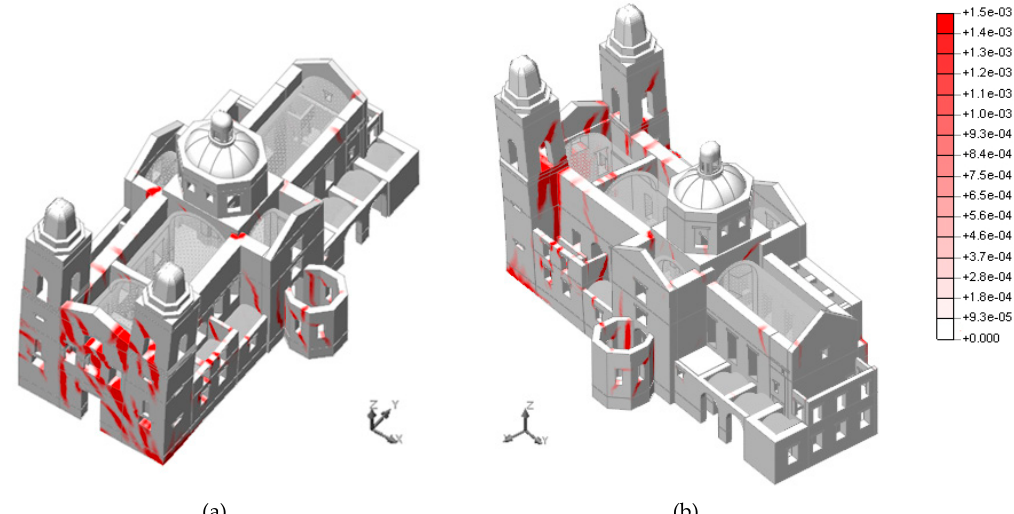
Figure 11. Crack width associated with the maximum principal strain at the end of the capacity curve for the pushover analysis in the positive transversal direction (+XX). ( a ) South-West view; ( b ) South-East view. Units in m.